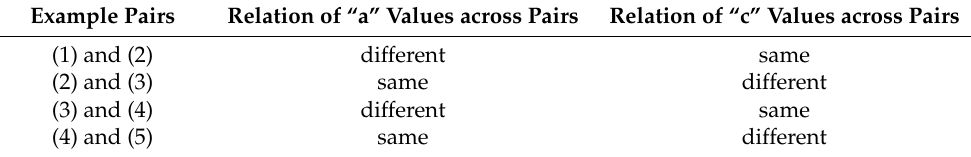
Table 2. Example pairs of warm-up problems. Example Pairs Relation of “a” Values across Pairs Relation of “c” Values across Pairs (1) and (2) different same same different different same same